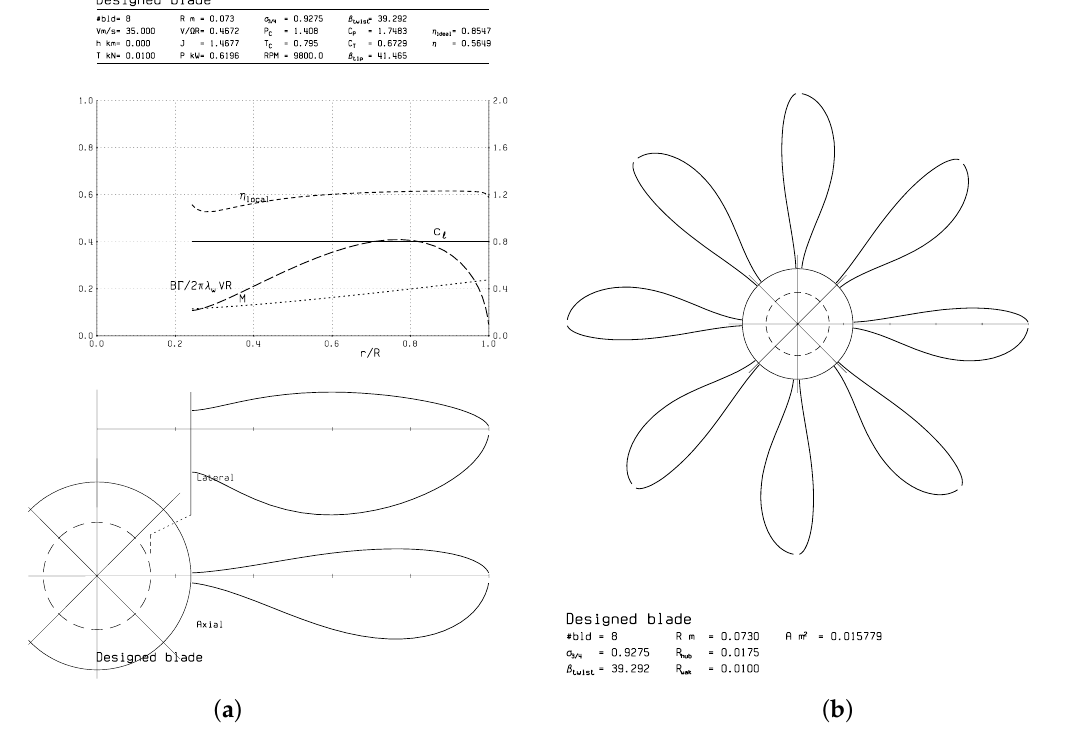
Figure 3. XROTOR design output: ( a ) blade data; ( b ) propeller